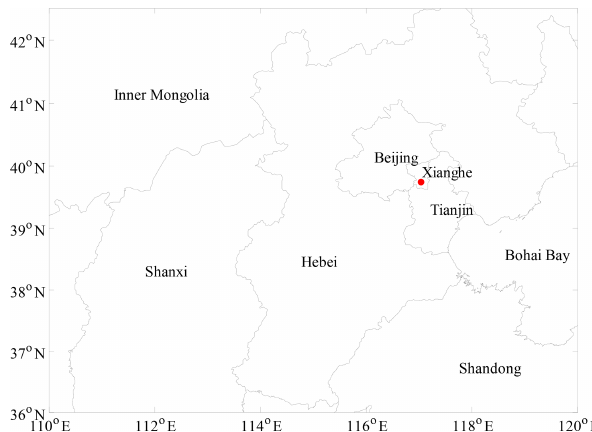
Figure 1. The location of the sampling site, which is marked with a red dot. The black lines are provincial boundary lines of each